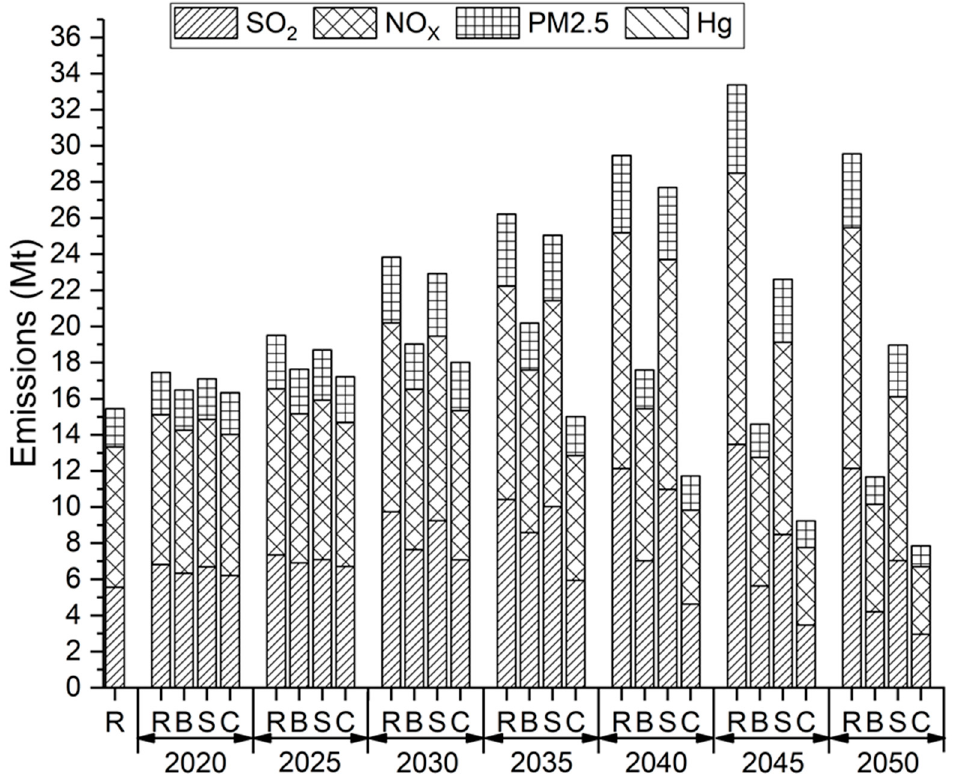
Figure 5. Emissions of air pollutants in the power industry. Table 4. Emission reduction potential in power industry (Mt).